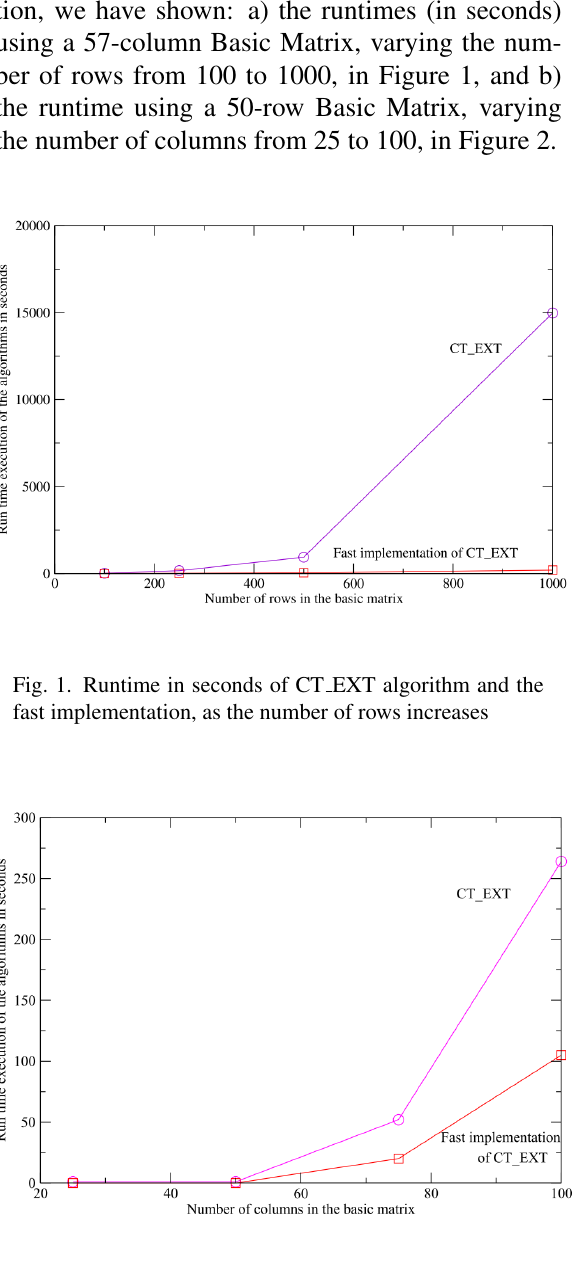
Fig. 2. Runtime in seconds of CT EXT algorithm and the fast implementation, as the number of features